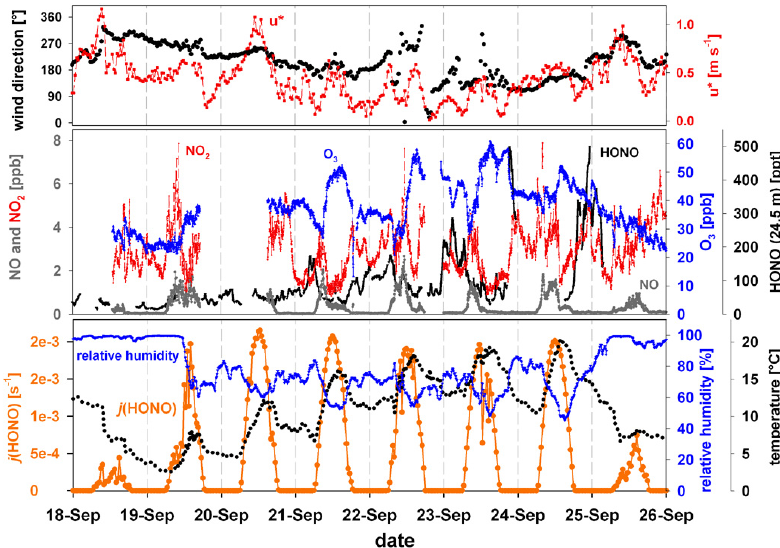
Fig. 3. The upper panel shows the wind direction above canopy (32m) and the friction velocity ( u ∗ ) at the top of the canopy (21m). In the middle panel the trace gases (NO, NO 2 , O 3 and HONO) measured above the canopy (24.5m) are presented. Time series of the HONO photolysis frequency j (HONO) parameterized from the measured NO 2 photolysis frequency at a height of 28m (orange line and dots), relative humidity and air temperature measured at the canopy top (21m) from 18 (00:00CET) to 26 (00:00CET) September 2007 at the “Waldstein-Weidenbrunnen” research site are presented in the lower